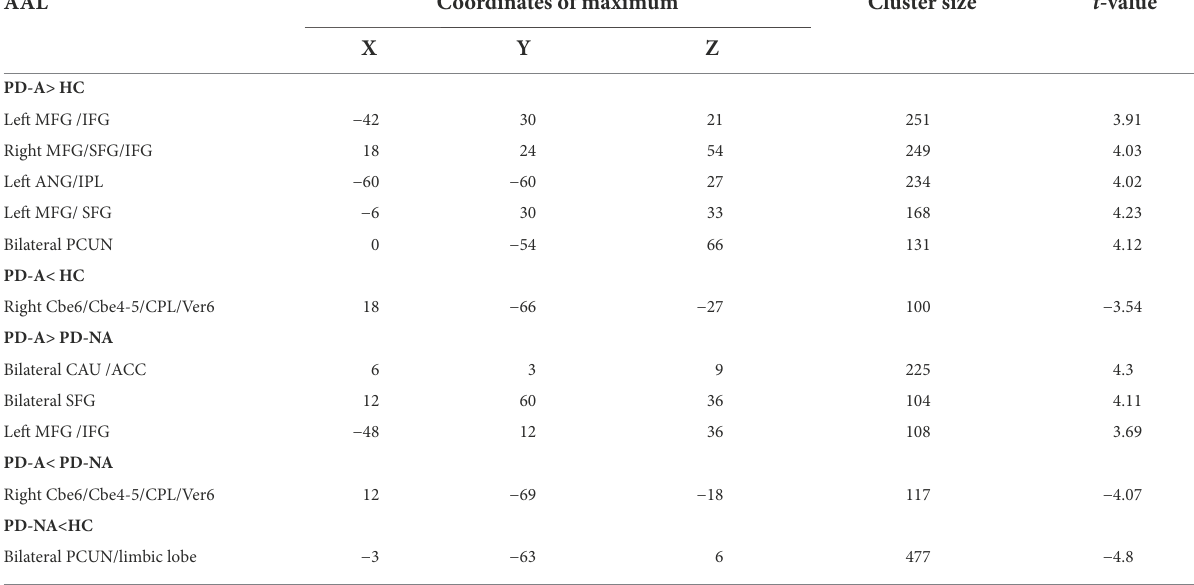
TABLE 3 Brain areas with significant between-group ReHo